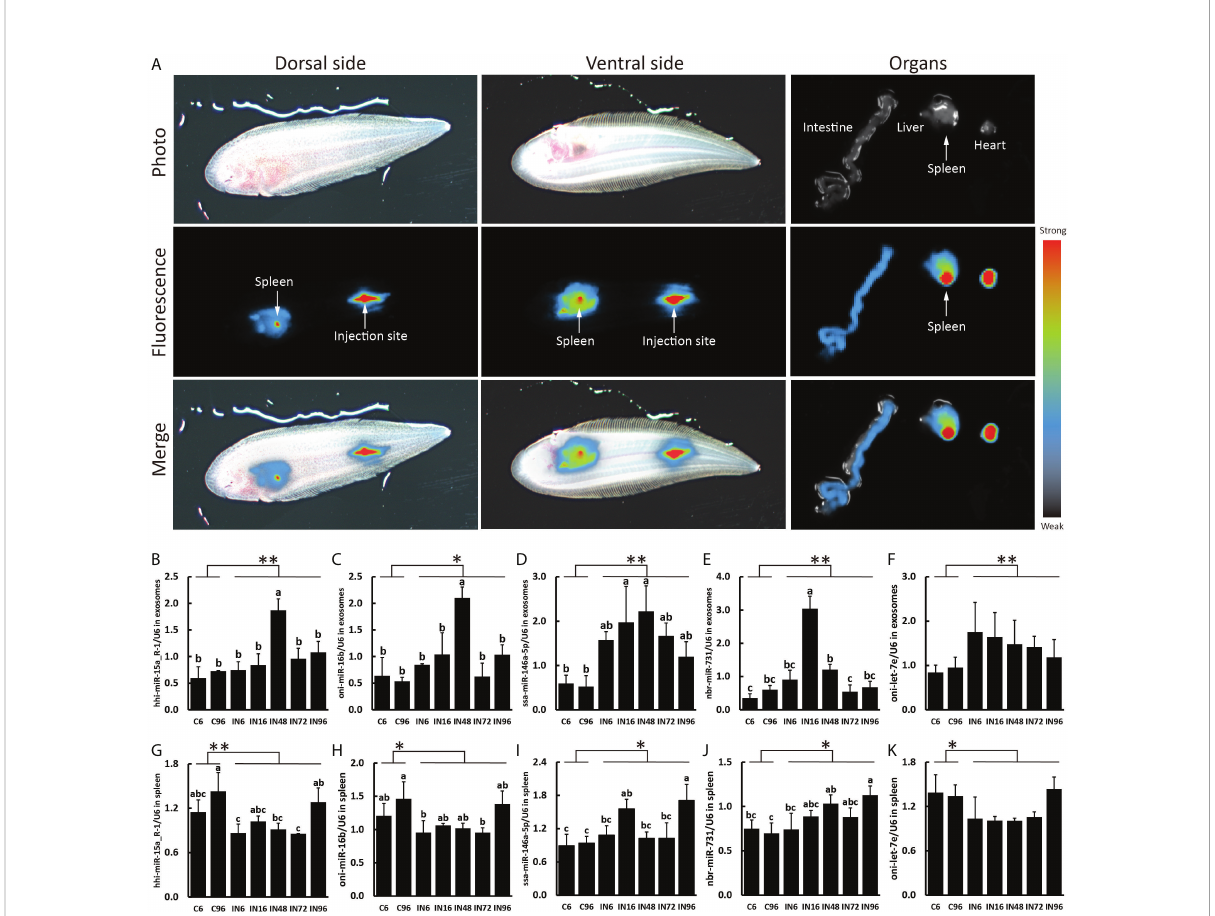
FIGURE 5 Plasma exosomes biodistribution and expressions of miRNA candidates in exosomes and spleen. (A) Representative images of the plasma exosome biodistribution in live fi sh and their organs at 6 h after Dorsal aorta microinjection of DiR-labeled exosomes derived from plasma. Images of dorsal and ventral sides and organs were captured by IVIS. The expressions of hhi-miR-15a_R-1 (B) , oni-miR-16b (C) , ssa-miR-146a- 5p (D) , nbr-miR-731 (E) , oni-let-7e (F) in exosomes and the expressions of hhi-miR-15a_R-1 (G) , oni-miR-16b (H) , ssa-miR-146a-5p (I) , nbr- miR-731 (J) , oni-let-7e (K) in spleen. Expression values were normalized by U6. Values are means (n=3) with their standard deviations represented by vertical bars. a,b,c Mean values with unlike letters were signi fi cantly different ( P < 0.05, One-way analysis of variance, Tukey ’ s Test). ** P < 0.01; * P < 0.05 versus the